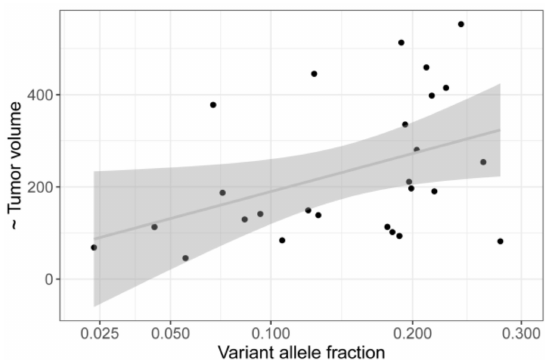
Figure 3. Linear regression of tumor volume on variant allele fraction (VAF) in 28 mutation positive samples. There is a trend of larger tumors showing higher VAF ( p =